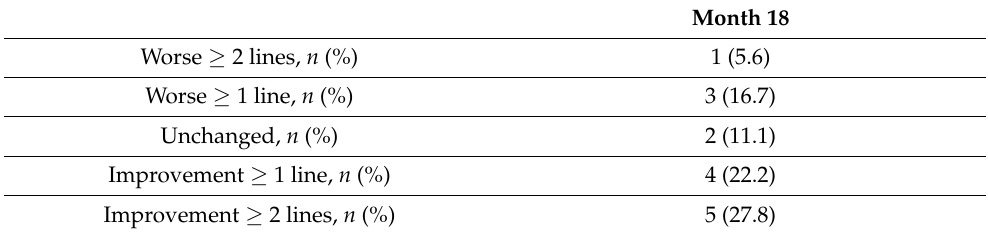
Table 4. Proportion of eyes which experienced changes in best-corrected visual acuity throughout the study. Changes in visual acuity were only assessed in eyes which underwent XEN implant